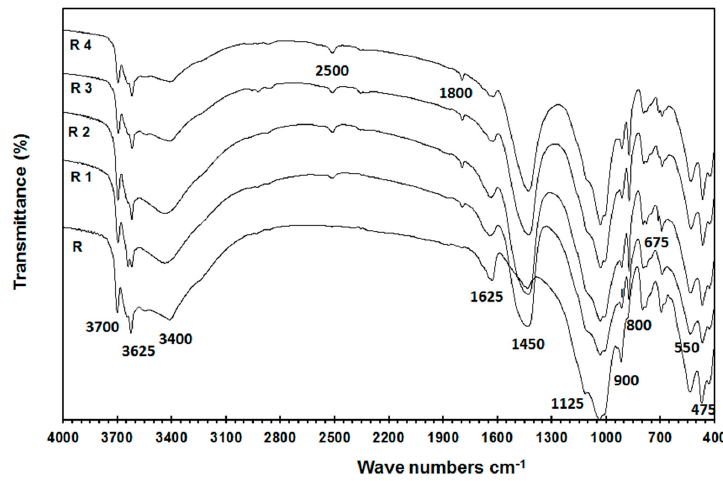
Figure 8 . Fourier transformed infrared spectrometer (FTIR) spectra of the specimens of different mixes that were cured for two weeks.